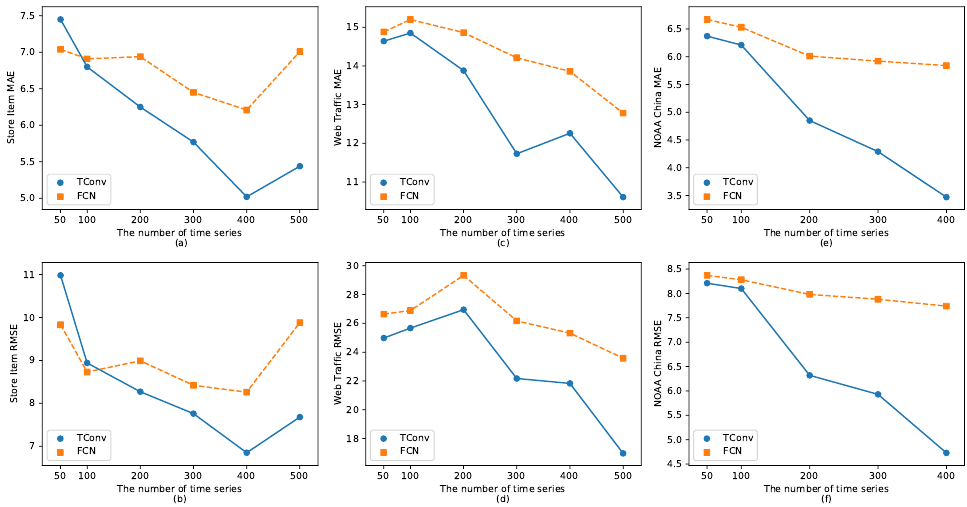
Figure 6. The influence of interaction matrix generator structure on prediction